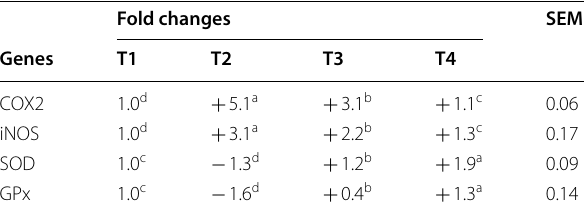
infection by E. coli (O157: H7) +